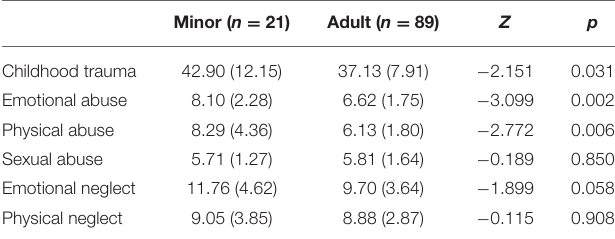
TABLE 3 | The difference of childhood trauma between minor group and adult